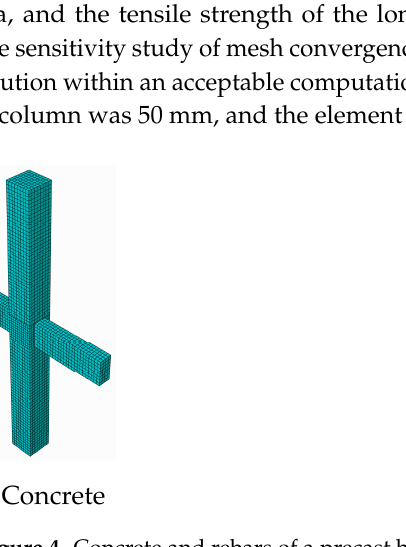
Table 1. Working cases in the numerical simulations.